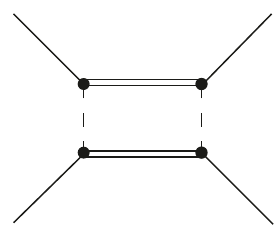
Figure 10. Diagram contributing to four-fermion operators. The double line denotes a mass eigenstate before EWSB.